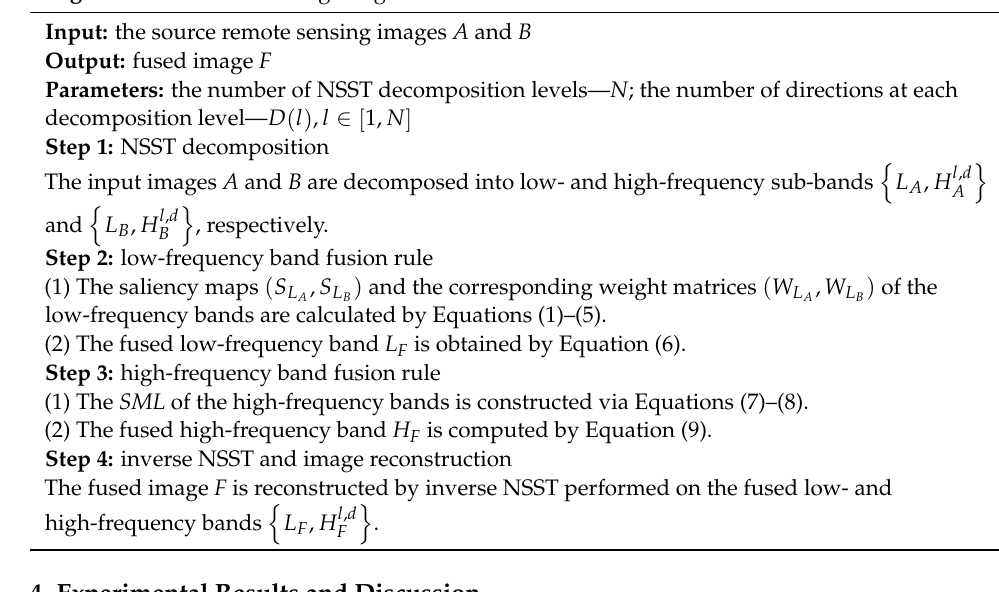
Algorithm 1 Remote sensing image fusion via